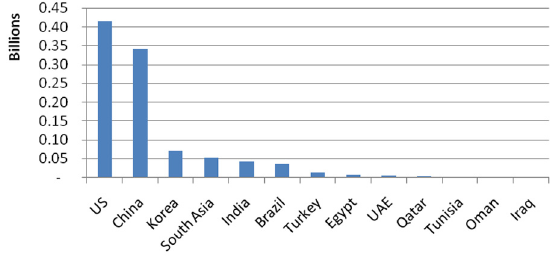
Figure 2. GERD in 2015; selected